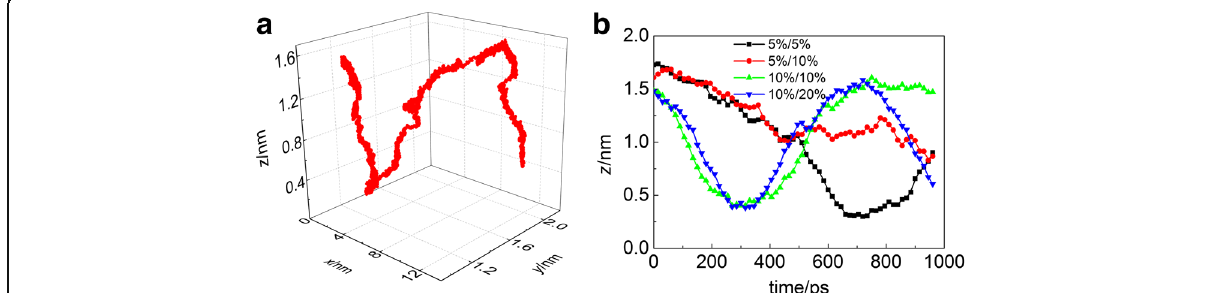
Fig. 2 a The three-dimensional motion trajectory of a C atom on carbon nanotube. The hydroxyl groups ’ ratio on carbon nanotube and Si substrate is 10 and 20%, respectively. b The coordinate of a C atom on carbon nanotube in the z direction as a function of time. The hydroxyl groups ’ ratio on carbon nanotube and Si substrate is 5%/5%, 5%/10%, 10%/10%, and 10%/20%,